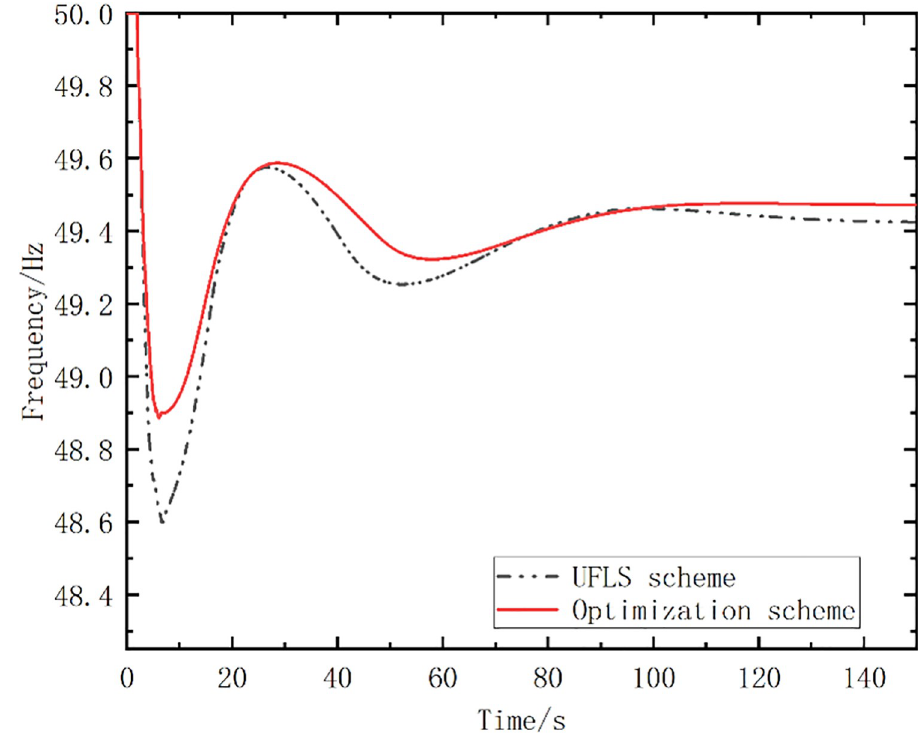
Fig 13. Simulated frequency